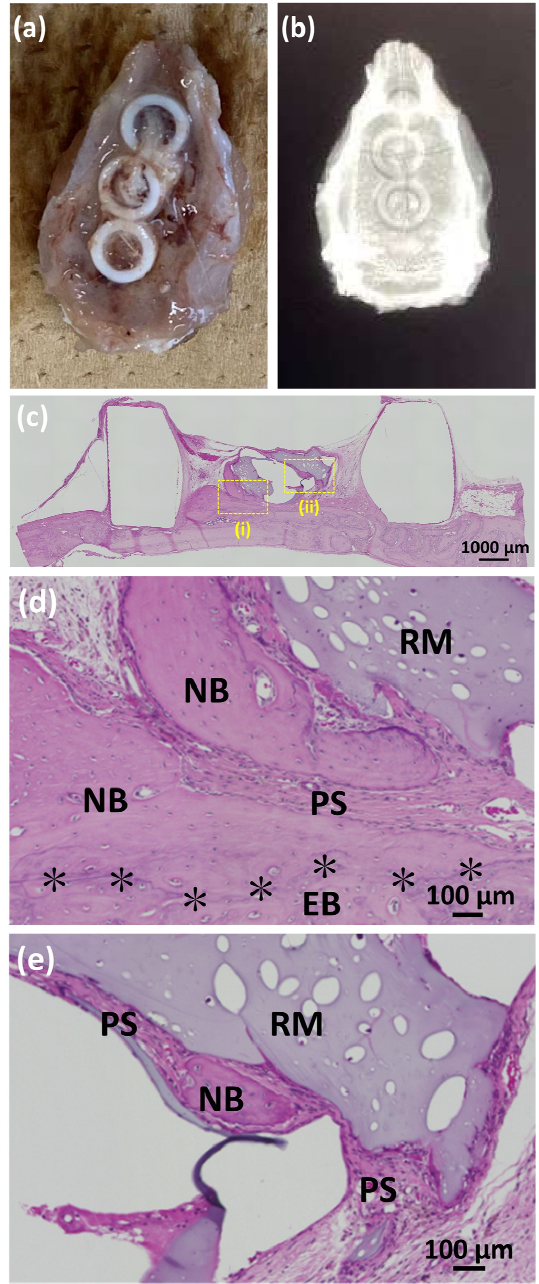
Figure 15. ( a ) Photo and ( b ) soft X-ray image of three test SG II samples (SG II*BMP (+)) inside Teflon rings placed on one rat cranial bone after 8 weeks of placement; ( c ) the low magnified HE-stained image of the cranial bone of a rat 8 weeks after the placement of test SG II (SG II*BMP (+)); ( d ) higher magnified HE images of the yellow rectangle (i) of Figure 15c; and ( d , e ) higher magnified HE images of the yellow rectangle (ii) of Figure 15c. Note: RM, residual material; PS, periosteum; NB, new bone; EB, existing bone. Note: * indicates the border between NB and